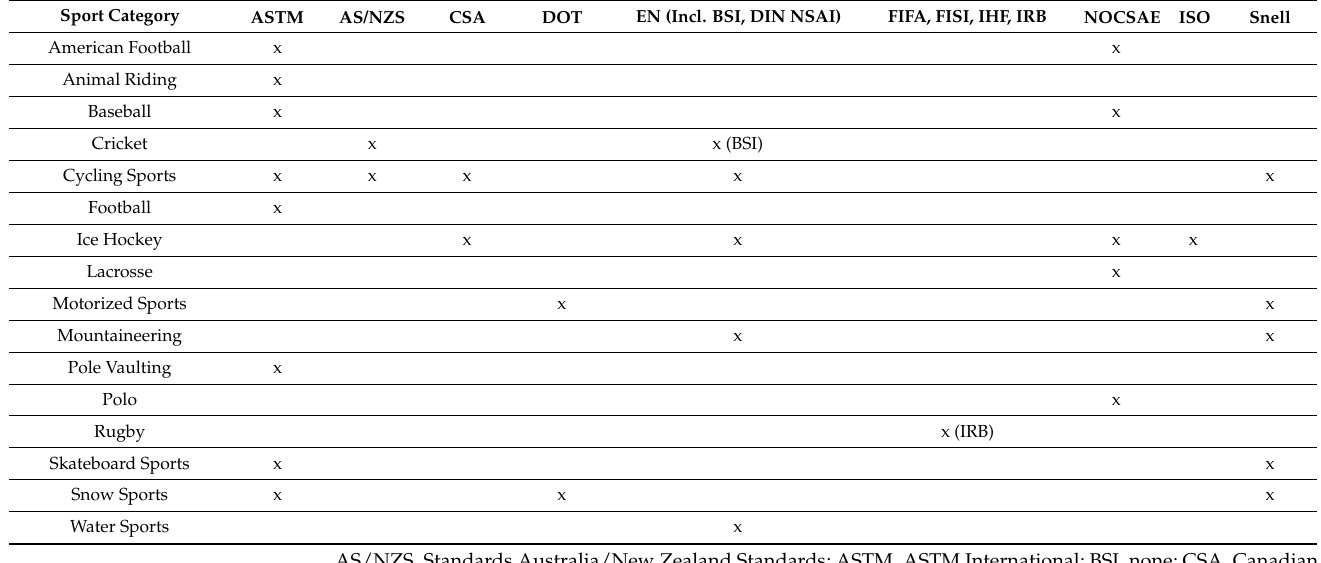
Table 1. Sports helmet standards (‘x’ indicates standard) [14,21].